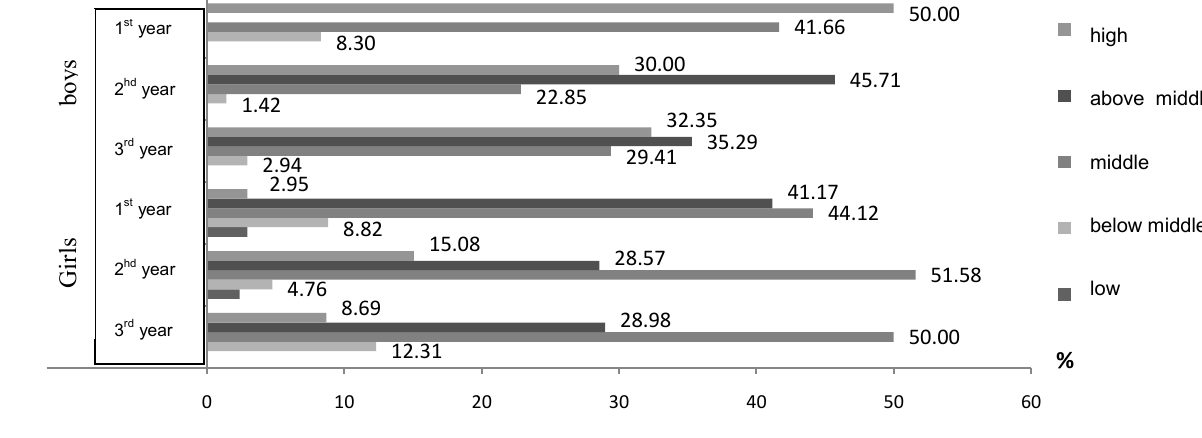
Fig.6. Self assessment of motion functioning of SRU “Bel SU” students